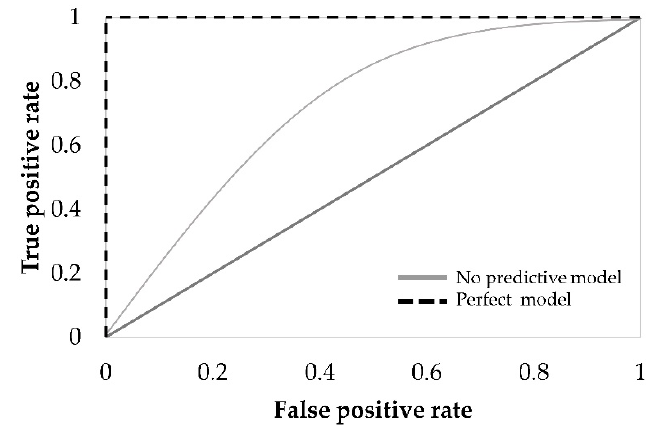
Figure 1. The receiver operating characteristic (ROC) curve.